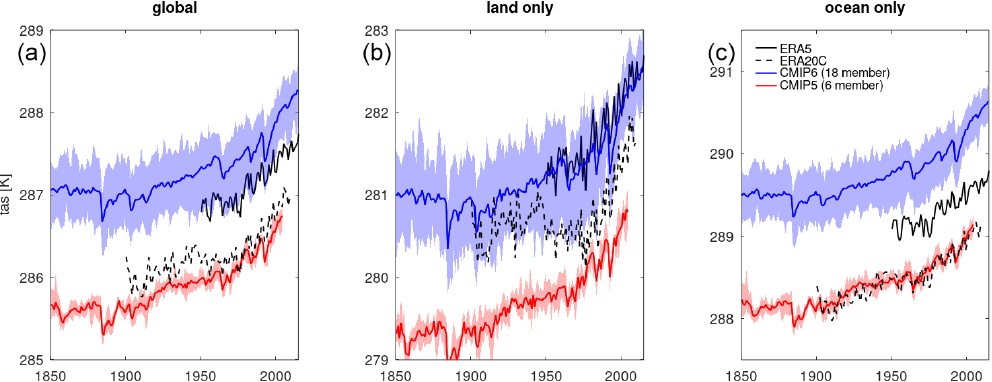
Figure 4. Global annual mean TAS (in K) from the EC-Earth2.3 (red, for CMIP5) and EC-Earth3 (blue, for CMIP6) ensembles for (a) global mean, (b) land only, and (c) ocean only. Ensemble means are shown as thick lines, and the ensemble spread is shown as a shaded area. Global annual mean TAS from the ERA5 (black, solid) and ERA-20C (black, dashed) reanalyses is shown for comparison.